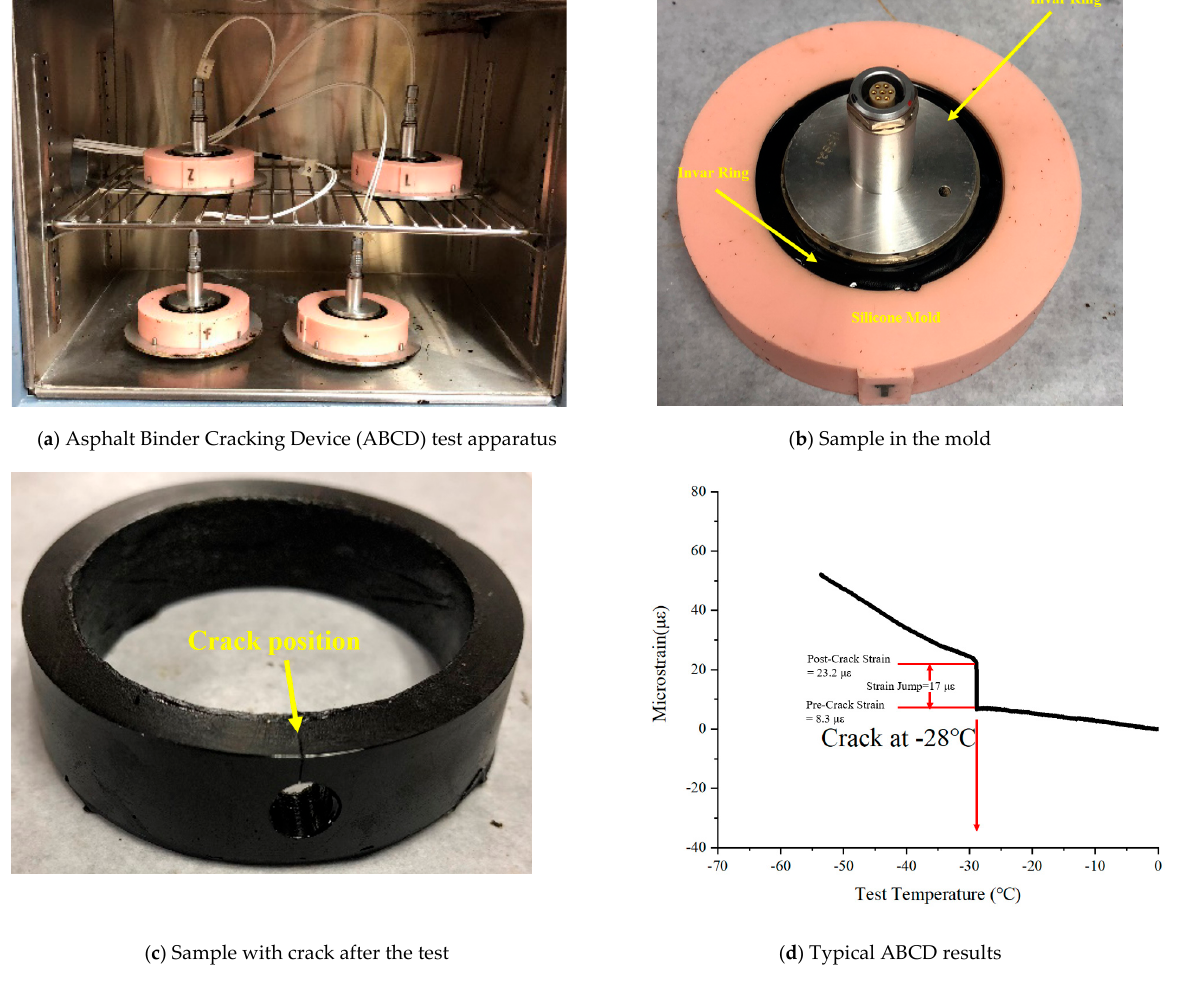
Figure 5. The Asphalt Binder Cracking Device (ABCD) test apparatus and procedure: ( a ) Asphalt Binder Cracking Device (ABCD) test apparatus; ( b ) Sample in the mold; ( c ) Sample with crack after the test; ( d ) Typical ABCD results.